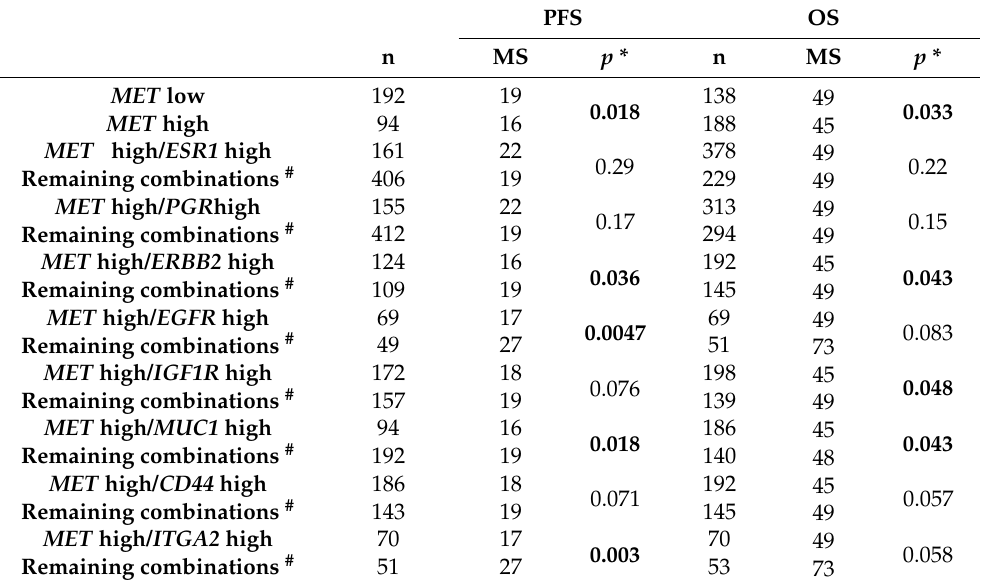
Table 6. Univariate survival analysis of dual expression of MET and other biomarker